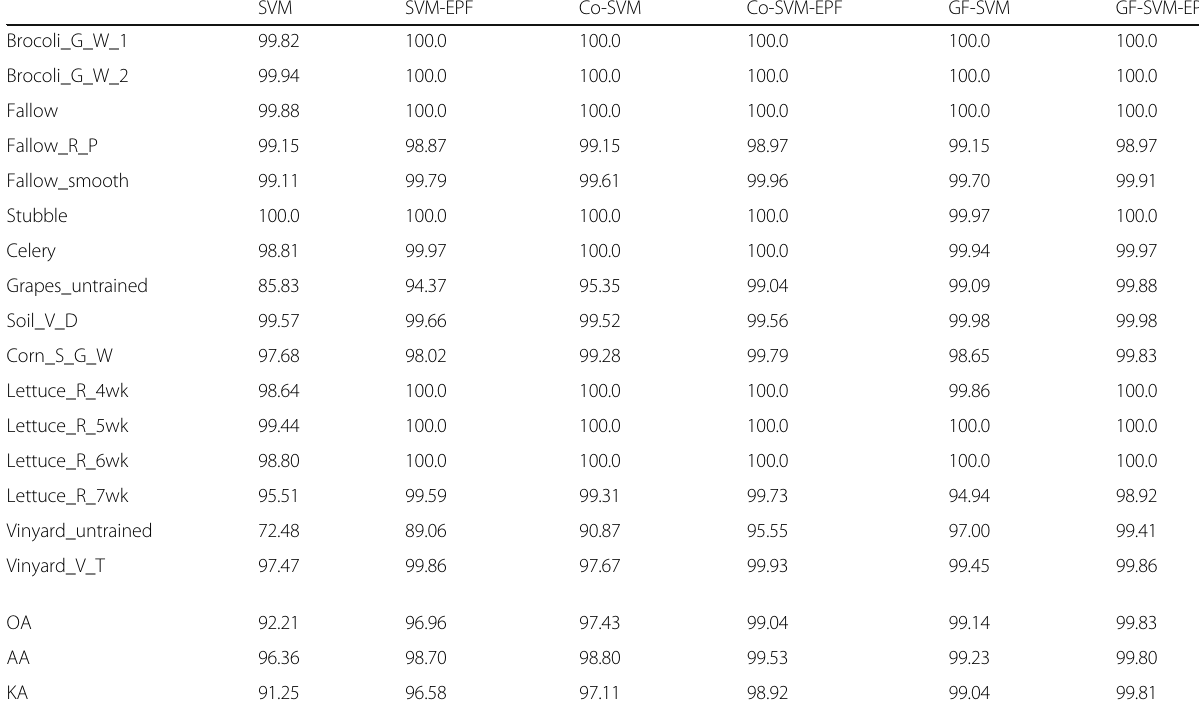
Table 3 Classification accuracy on the Salinas dataset (10% samples for